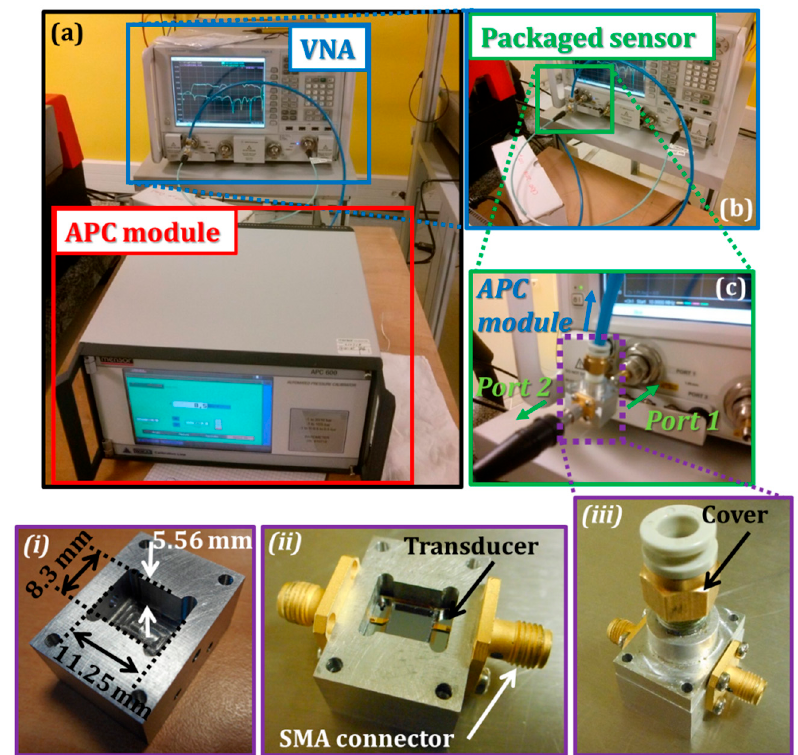
Figure 3. ( a – c ) Experimental setup for measuring the variation of the scattering parameters (S-parameters) when pressure is applied on the packaged sensor [21]. Insets ( i ), ( ii ) and ( iii ) represent photos of the sensor package. With its package, the dimensions of the pressure sensor are 36 mm × 24 mm × 42 mm.